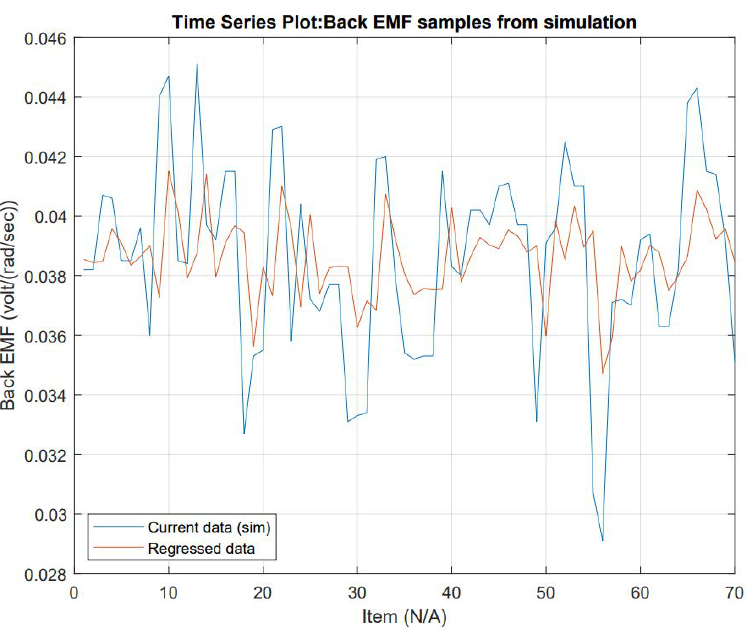
Figure 11. Regressed data displayed with current data to show regression fitting accuracy. Regres- sion was produced using an ARMA model. The current ARMA Model is not fitting the current data; there are some causes for this: first, the data mean is not zero, the proposed model is not adding an integrated ( I ) part, the time series analysis using Ljung–Box concluded the data values are